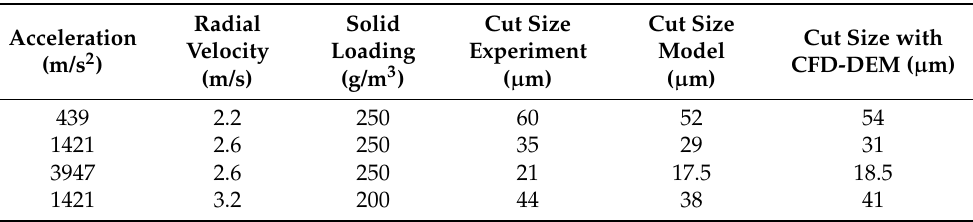
Table 3. The comparison of the cut size of the experiment, the mathematical model and the simulation of particle–particle interaction under different operating conditions.